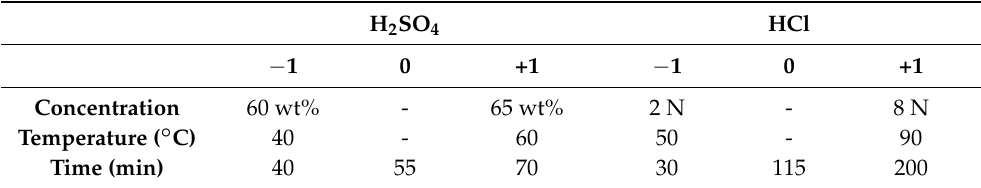
Table 1. Controllable process factors and their respective levels for CNC acid hydrolysis length optimization.